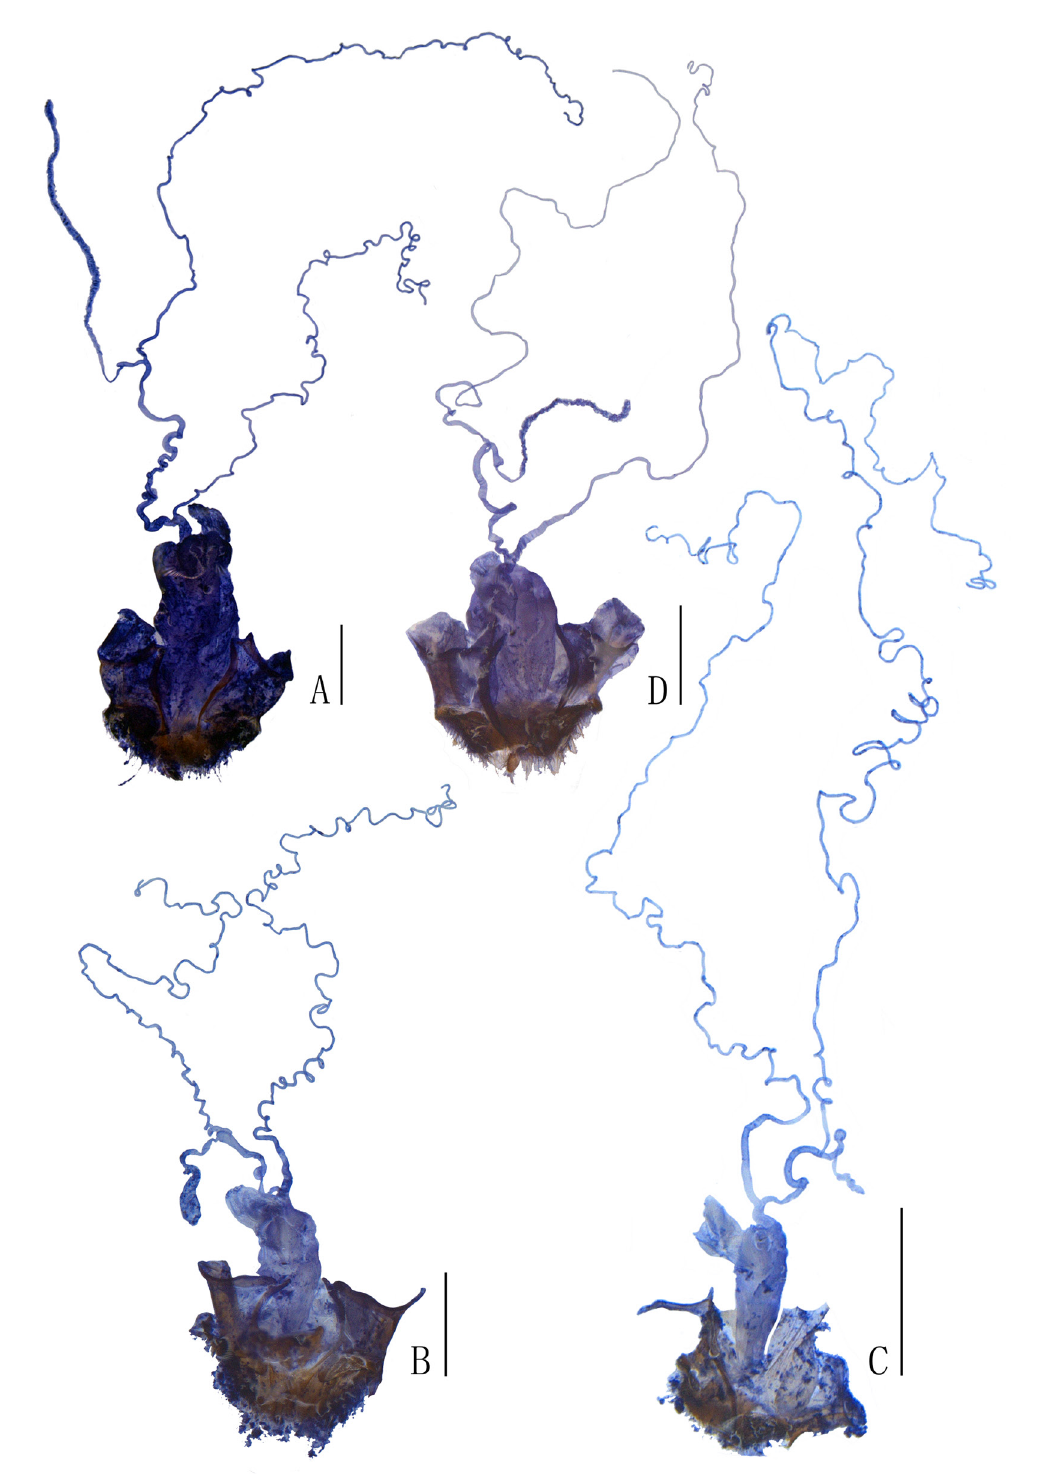
Fig. 12. Female reproductive system, ventral view. A . Stenothemus singularicollis (Pic, 1933) comb. nov. (MHBU, Shaanxi). B . S. gracilis Y. Yang & X. Yang sp. nov., paratype (IZAS IOZ(E) 225787). C . S. flavicollis Y. Yang & S. Ge sp. nov., paratype (MHBU HBU(E) 410039). D . S. laticornis Y. Yang & H. Liu sp. nov., paratype (MHBU HBU(E) 410047). Abbreviations: see Material and methods. Scale bars = 0.5